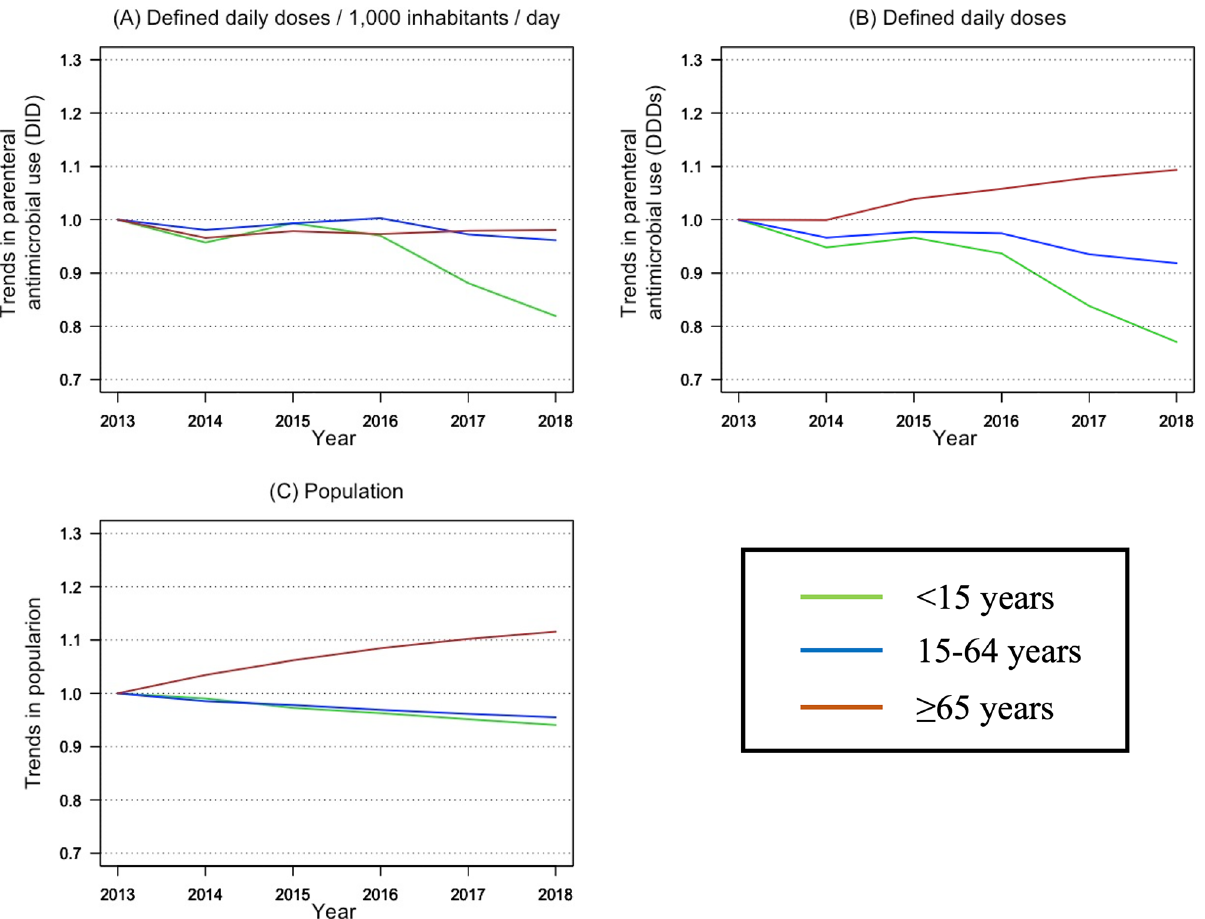
Figure 1. Trends in parenteral antimicrobial use and the national population from 2013 to 2018 according to age group. The graphs show the trends as ratios of each metric using the 2013 values as the reference points. ( A ) Trends in DID. ( B ) Trends in DDDs. ( C ) Trends in population numbers. DDD, defined daily dose; DID, defined daily doses/1000